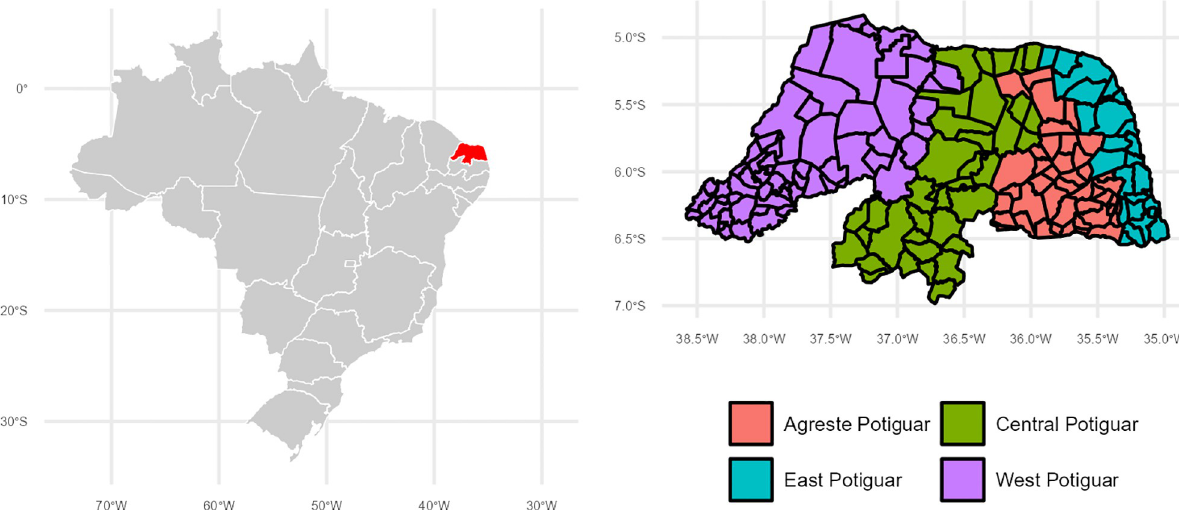
Fig 1. Location and Mesoregions of Rio Grande do Norte. The image on the left highlights the northeastern location of Rio Grande do Norte (in red) within Brazil. The image on the right shows the four Mesoregions in Rio Grande do Norte and municipalities within each region. This figure was created using the geobr package in R